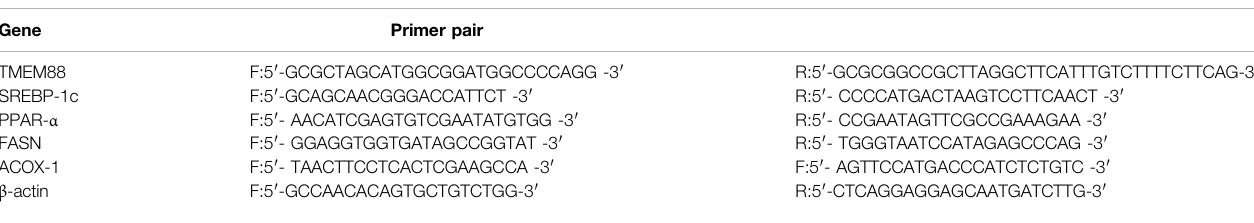
TABLE 1 | Primer sequences for quantitative real-time reverse transcription polymerase chain reaction.